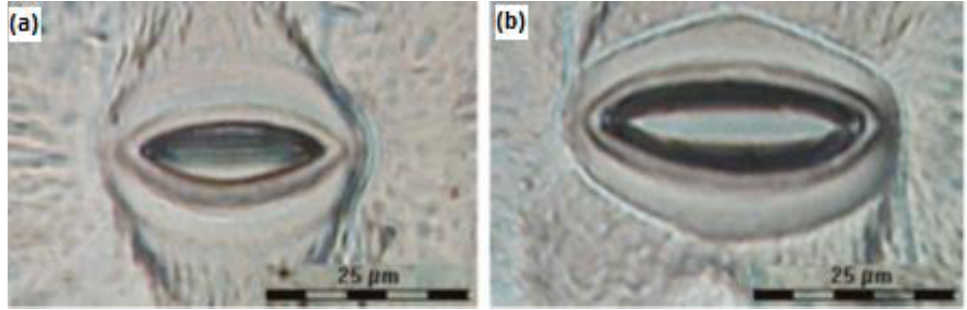
Figure 3. Light microscope images of stomata in 60% relative air humidity (RH) ( a ) and 90% RH ( b ). The images are of imprints of the abaxial side of the leaves during the light period [66].